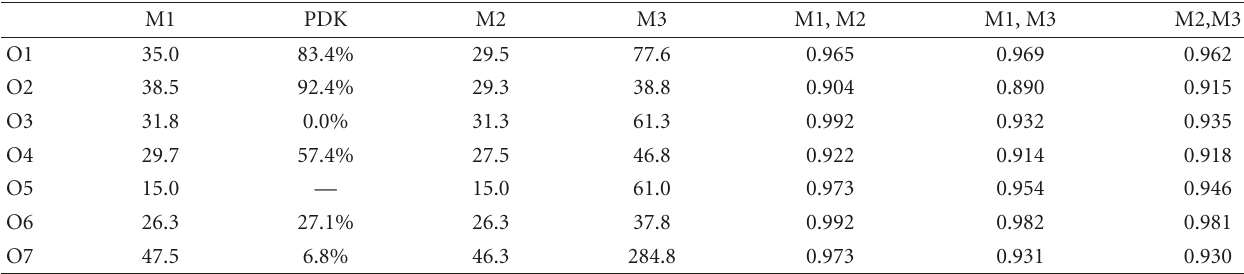
Figure 9: (a) A segmentation of the left caudate nucleus. (b) The result of dilating the binary image with a circular structuring element of radius 1. The similarity value between these two masks is 0.87. The di ff erences in the experiments using distinct methods on this object (O2) are less significant than this small dilation. Table 3: The percentages of di ff erent κ s values (PDK) in M1, the average numbers of user interactions for each object and method, and the average similarity values between di ff erent methods for a same object.